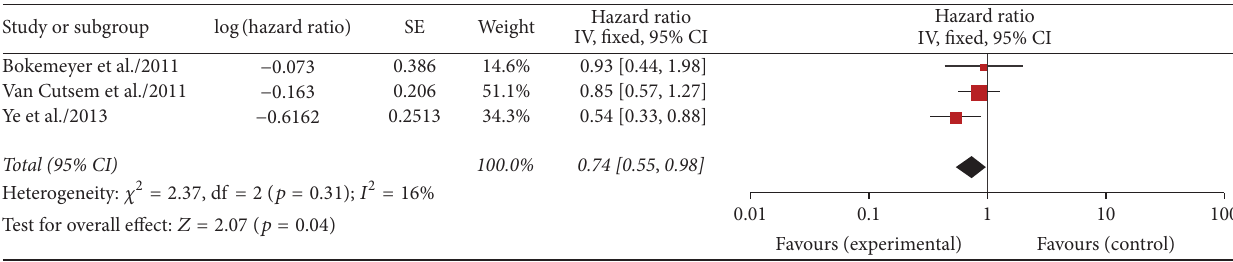
Figure 5: Meta-analysis OS comparing chemotherapy ± cetuximab in patients with liver-limited